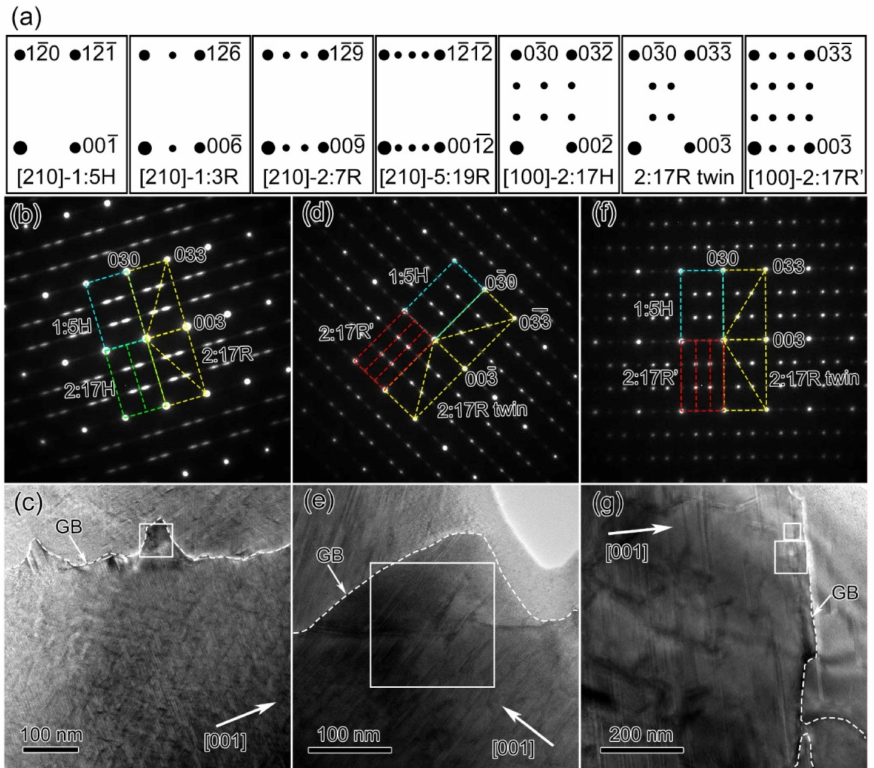
Figure 3. Single-crystal electron diffraction patterns for 1:5H, 1:3R, 2:7R, 5:19R, 2:17H, 2:17R twin variants, and the 2:17R’ phases ( a ). Selected area electron diffraction (SAED) patterns and bright-field TEM images for Sm 25 Co 46.9 Fe 19.5 Cu 5.6 Zr 3.0 magnets at different states: solution-treated ( b , c ), aged for 0.5 h at 810 ◦ C ( d , e ), and the final magnet ( f , g